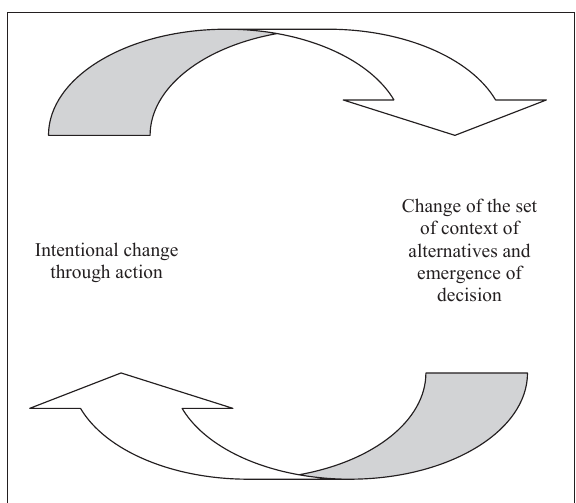
Figure 4. Ecological dynamics model of decision making: The de- cisions and the set of alternative actions emerge from the changes of the context generated by the performer her / himself